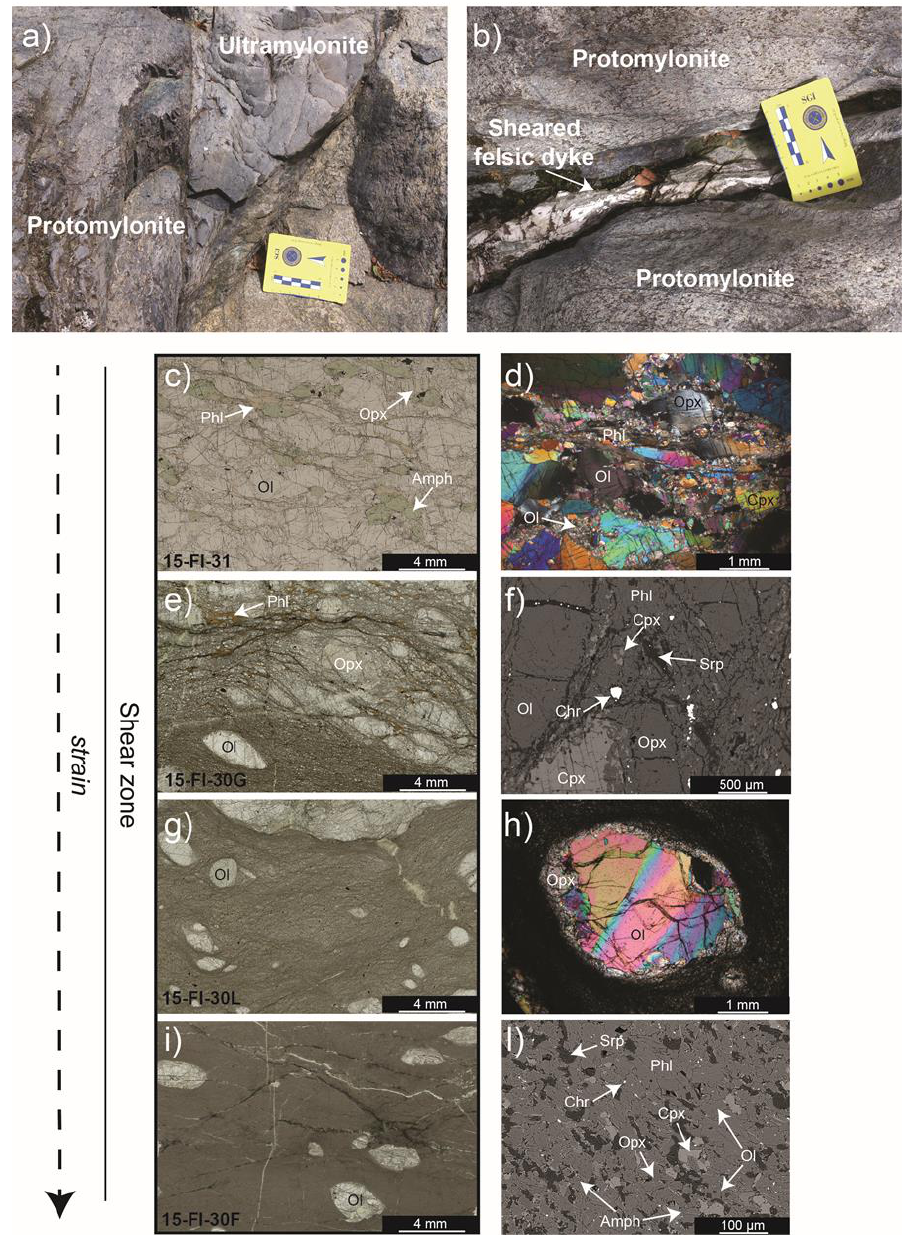
Figure 3. Shear zone macroscopic, petrographic, and microstructural features: ( a ) outcrop picture showing the textural variation from proto- to ultramylonite; ( b ) sheared felsic dyke within protomylonites; ( c , e , g , i ) Clippings of thin section natural light scans, the white box locates the higher resolution images presented on the right; ( d ) Cross-polarized light photomicrographs of protomylonitic harzburgite (31) characterized by elongated olivine and pyroxenes porphyroclasts surrounded by anastomosed seams of a fine-grained matrix; ( f ) Back-Scattered Electron (BSE) image of the mylonitic texture (30G); ( h ) Undulose extinction in a olivine porphyroclast surrounded by orthopyroxene recrystallized grains in the ultramylonite (30L); ( l ) BSE image of the ultramylonitic matrix (30F).